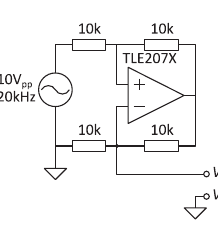
Fig.1: IPG current injection system.